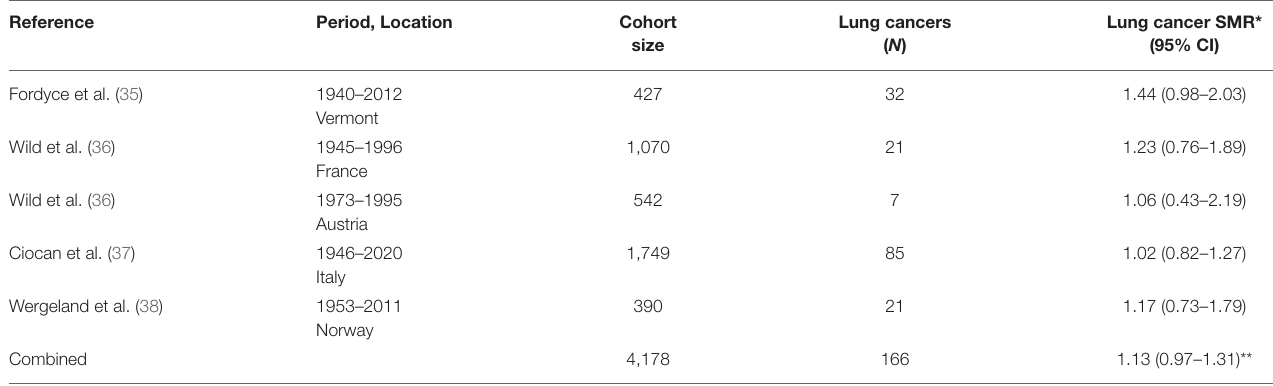
TABLE 2 | Lung cancer results from cohort studies of miners and millers of talc reportedly not contaminated with asbestos [updated from (34)].